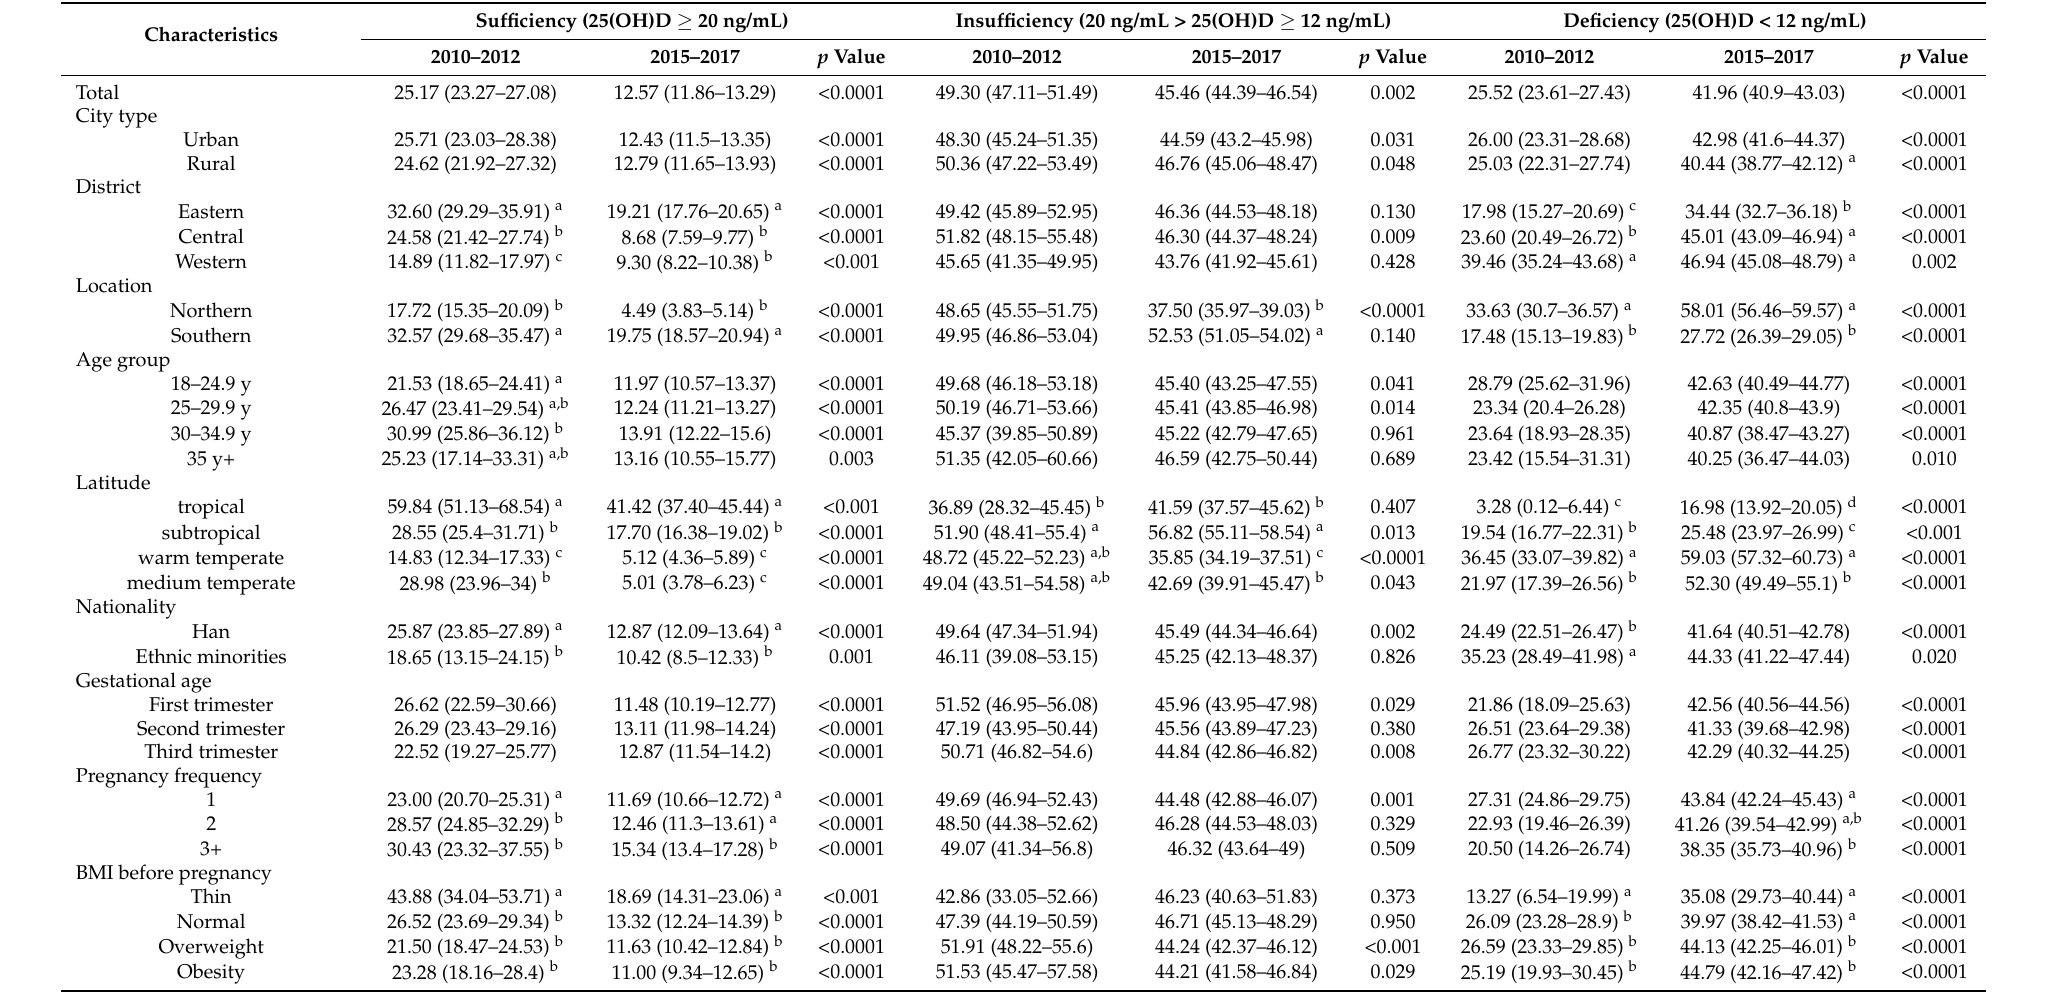
Table 2. Comparison of vitamin D status of pregnant women in CNHS 2010–2012 and CNHS 2015–2017 (%, 95%